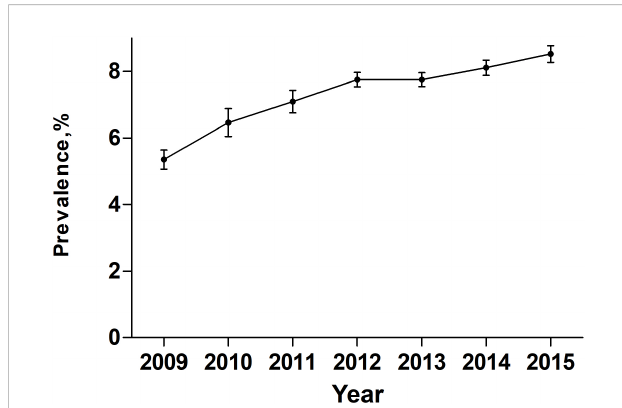
FIGURE 2 Prevalence of PEM in patients undergoing major cancer surgery patients between 2009 and 2015 in the United States.